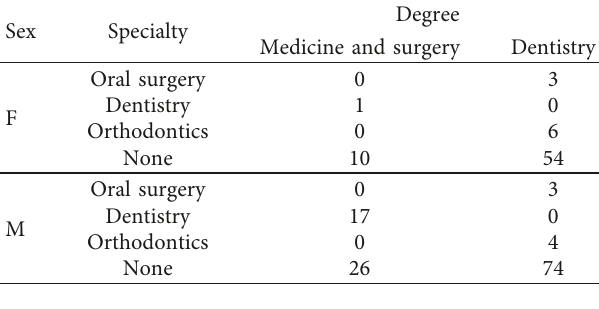
Table 1: Frequency distribution of study participants. Variables